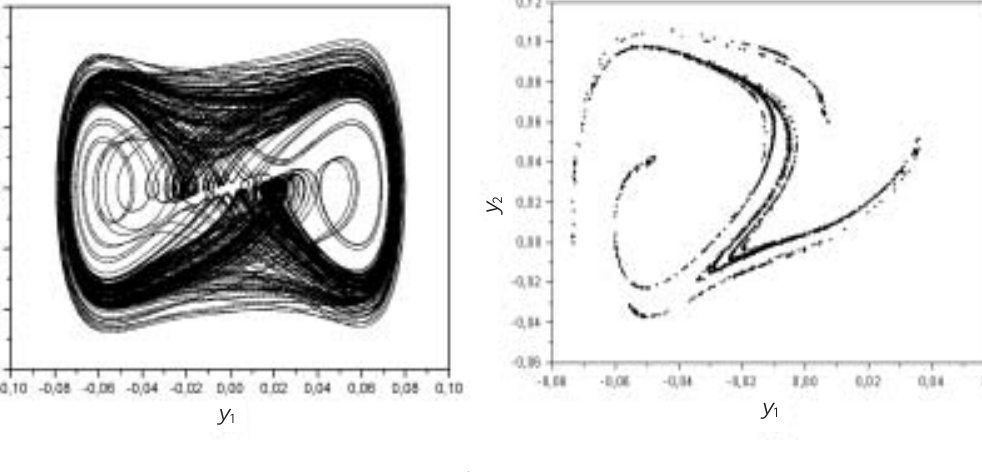
Fig. 12. Response for δ = 0 . 0777 and θ = 1 . 5 .